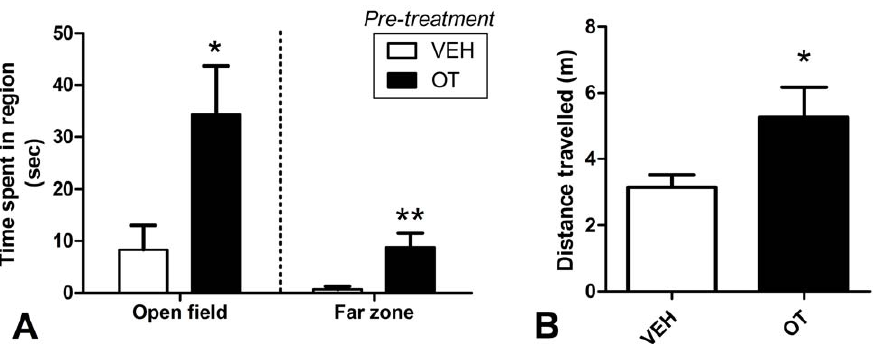
Figure 2. Emergence test. Results from the 5 min emergence test conducted 8 days after the cessation of 10 consecutive days of once per day treatments with either 1 mg/kg OT or VEH. A. Mean ( + SEM) seconds spent in the open field and in the third of the open field farthest from the hide box (far zone). B. Mean ( + SEM) metres travelled during the test. N=24 per condition. * Significantly different to VEH, p , 0.05 ** Significantly different to VEH, p , 0.01.